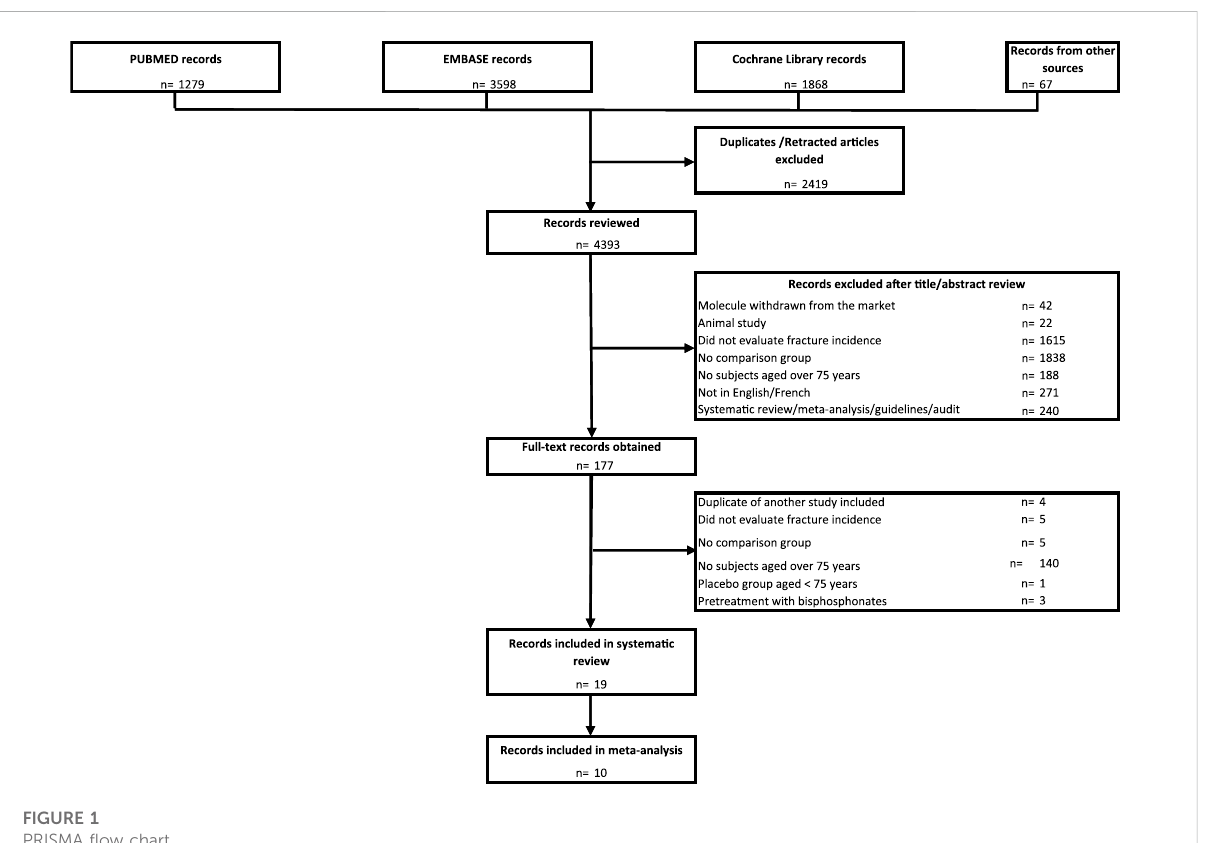
FIGURE 1 PRISMA fl ow